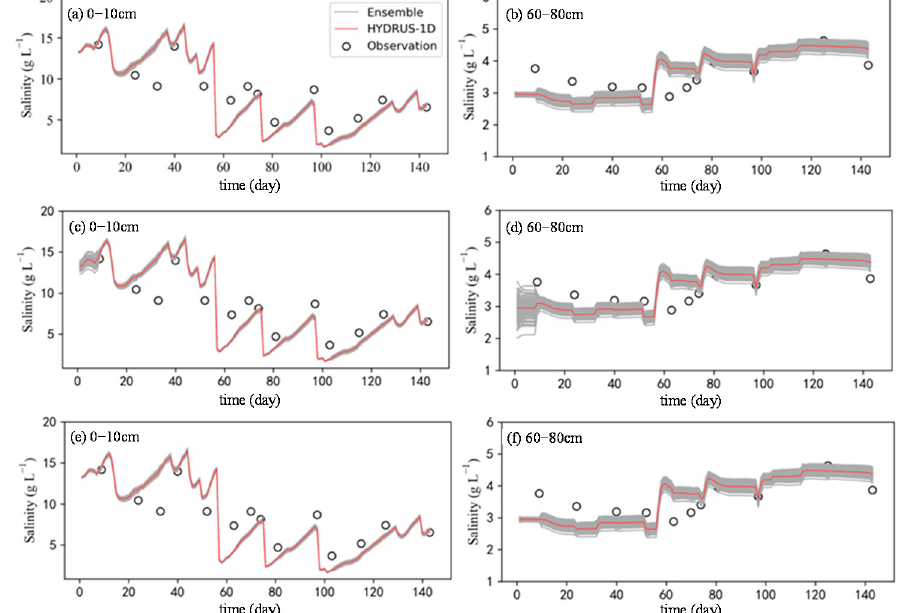
Figure 11. Simulated salinity at di ff erent depths with di ff erent initial perturbations of the soil moisture and salinity: ( a ) 0–10 cm, with standard deviations of 0.001 cm 3 cm − 3 for moisture and 0.1 g L − 1 for salinity; ( b ) 60–80 cm, with standard deviations of 0.001 cm 3 cm − 3 for moisture and 0.1 g L − 1 for salinity; ( c ) 0–10 cm, with standard deviations of 0.001 cm 3 cm − 3 for moisture and 1 g L − 1 for salinity; ( d ) 60–80 cm, with standard deviations of 0.001 cm 3 cm − 3 for moisture and 1 g L − 1 for salinity; ( e ) 0–10 cm, with standard deviations of 0.01 cm 3 cm − 3 for moisture and 0.1 g L − 1 for salinity; ( f ) 60–80 cm, with standard deviations of 0.01 cm 3 cm − 3 for moisture and 0.1 g L − 1 for